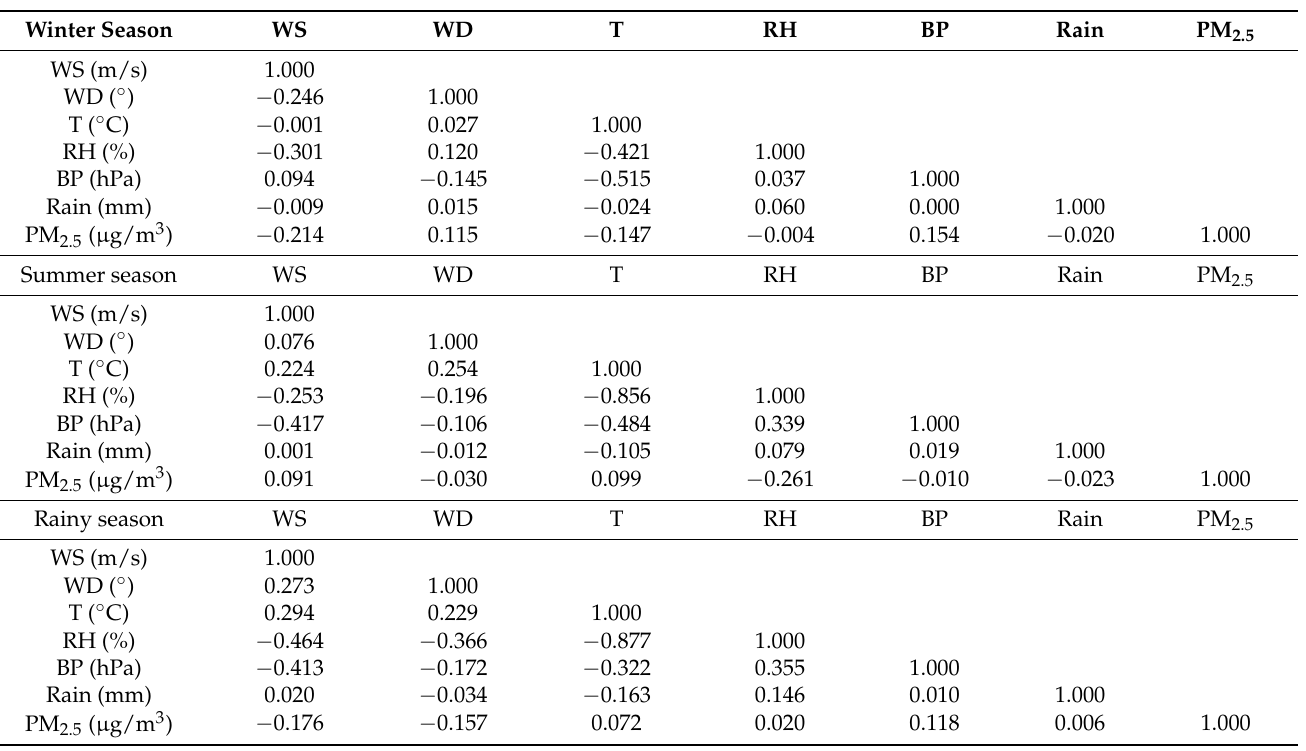
Table 2. Seasonal variations in the correlations between PM 2.5 concentration and meteorological factors obtained at a height of 30 m from 2015 to